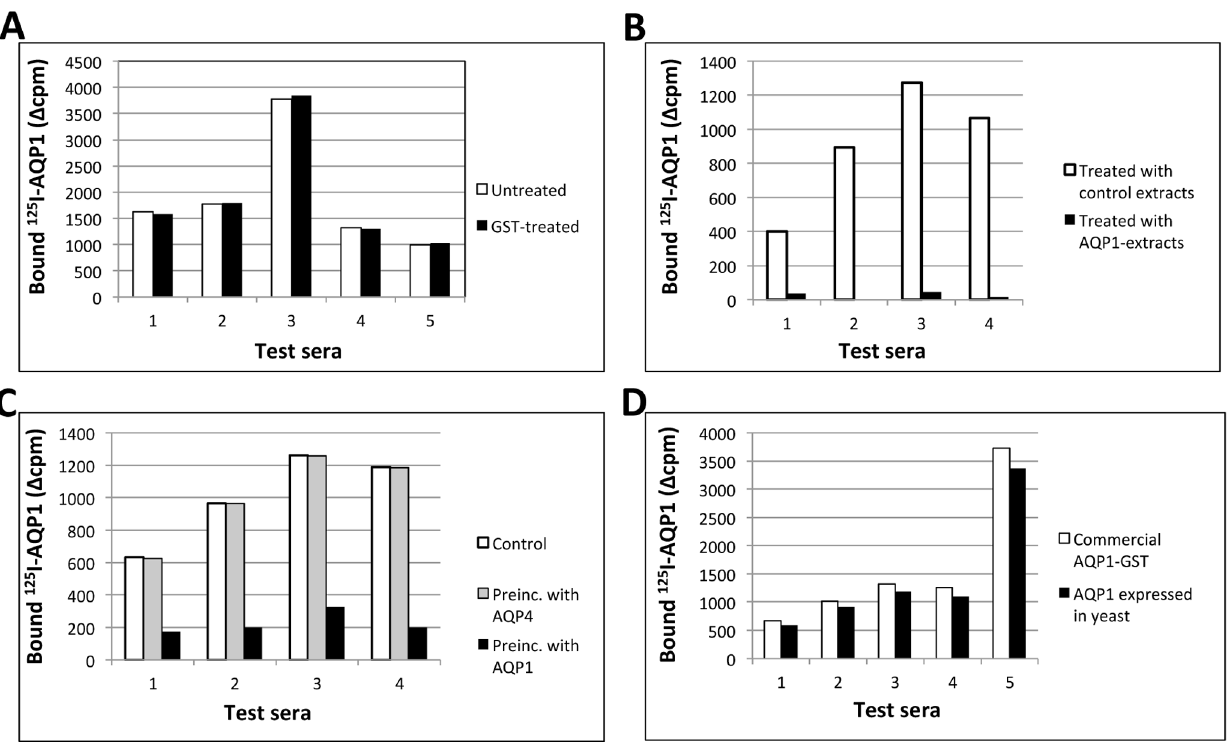
Figure 3. Anti-AQP1 specificity of the identified autoantibodies. ( A) Patient’s autoantibodies recognize the AQP1 moiety of AQP1-GST. Five sera that had tested positive for binding to the AQP1-GST fusion protein were preincubated with an excess of GST immobilized on Sepharose- glutathione beads, then were tested by RIPA using 125 I-streptavidin labeled AQP1-GST. (B) Binding of anti-AQP1 autoantibodies is specifically inhibited by an extract from AQP1-expressing HEK293 cells, but not control HEK293 cells. Four anti-AQP1-positive sera were preincubated with extracts prepared from either EGFP-transfected or AQP1-GFP-transfected HEK293 cells, then were tested by RIPA for binding to the commercial AQP1 preparation. (C) Binding of anti-AQP1 autoantibodies is specifically inhibited by yeast-expressed human AQP1. Four exclusively anti-AQP1-positive sera were preincubated with human AQP1 or AQP4 that had been expressed in yeast and purified or with BSA as control, then were tested by RIPA using 125 I-streptavidin-labeled commercial AQP1-GST fusion protein. (D) AQP1 autoantibody binding is independent of the source of AQP1. Both the commercial AQP1-GST fusion protein and the in house AQP1 purified from yeast were biotinylated, indirectly labeled by preincubation with 125 I- streptavidin, and used in the RIPA. Five anti-AQP1-positive sera and one serum sample from a healthy control (HC) were